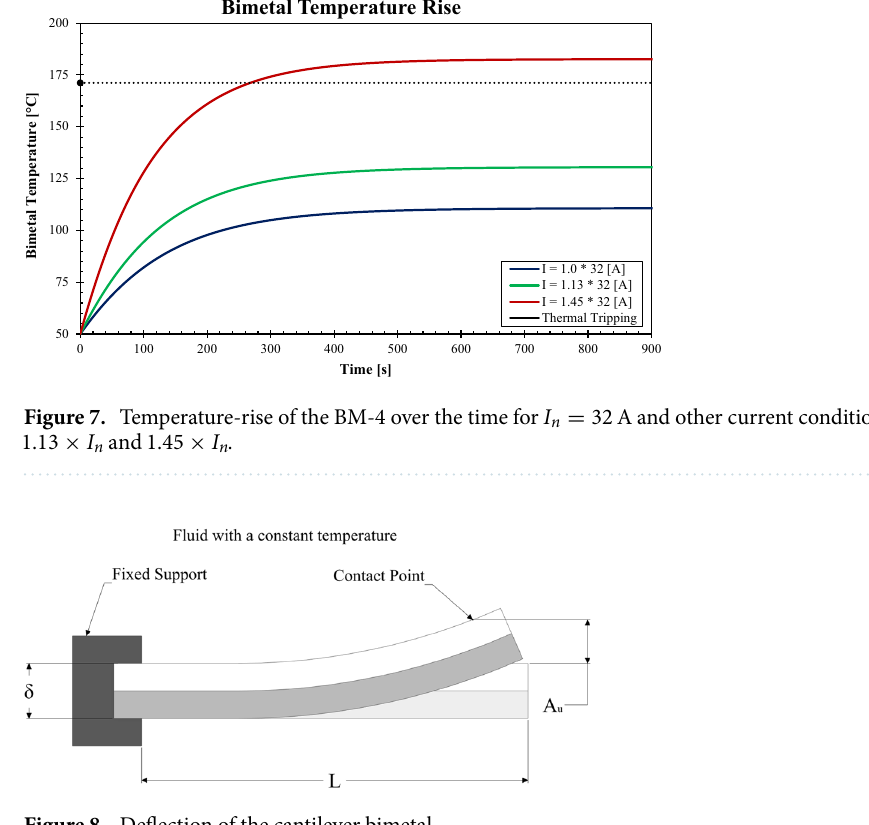
Figure 8. Deflection of the cantilever